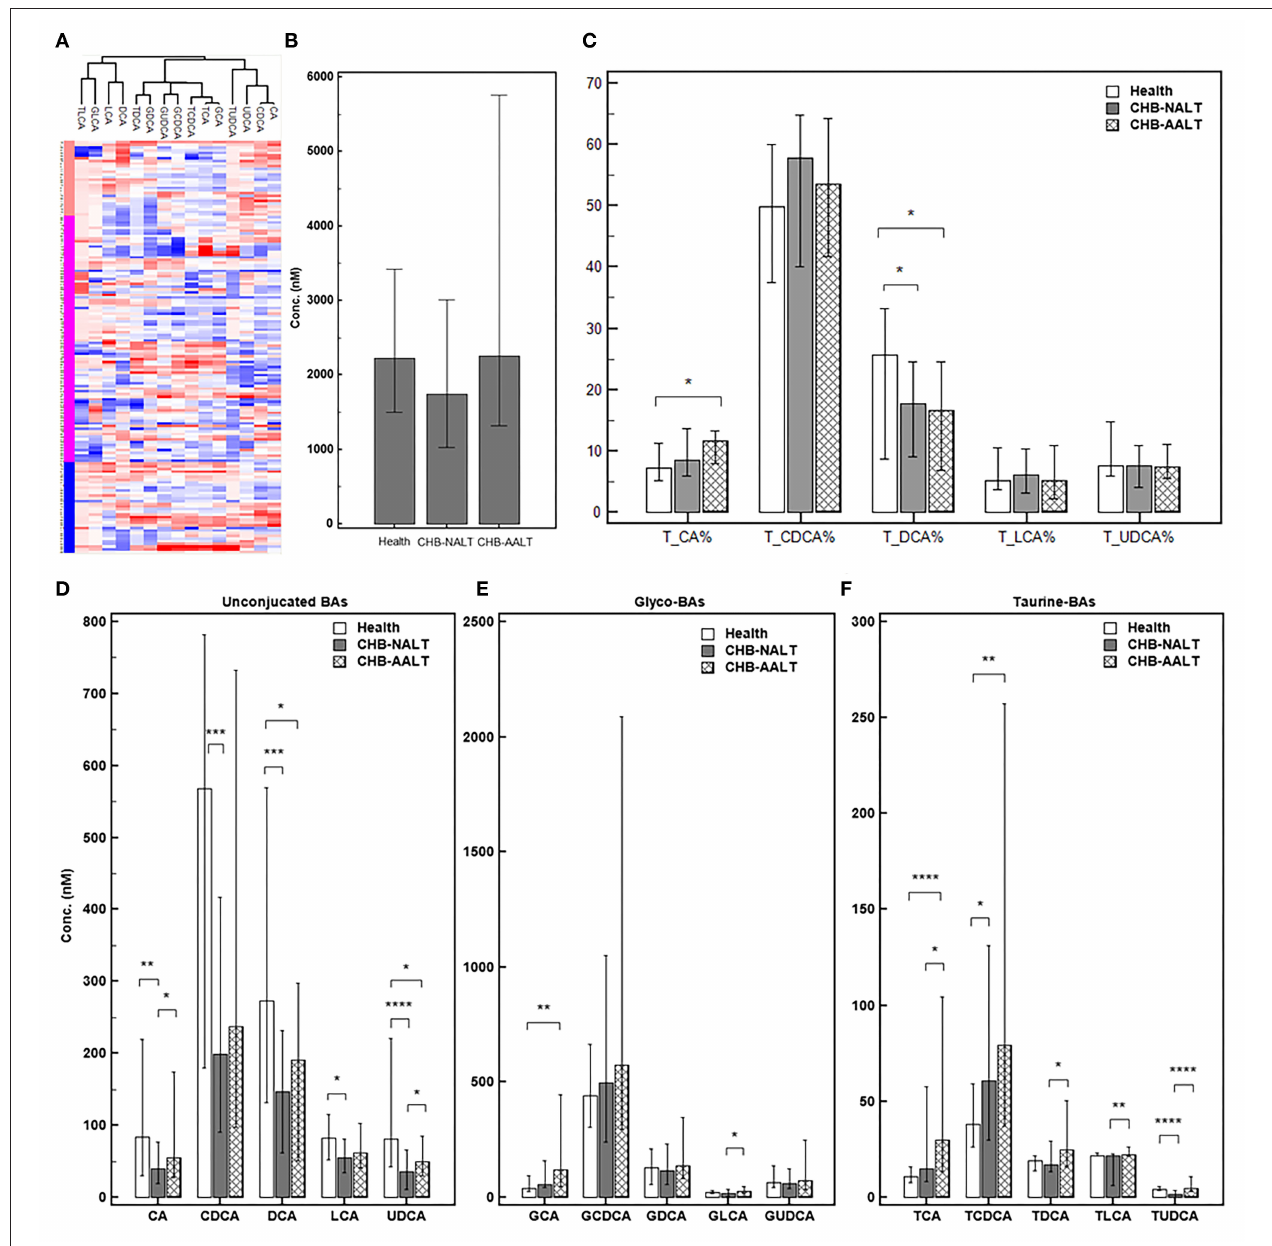
FIGURE 1 | Summary of BA profiles. (A) Bile acid profiles across all samples were visualized by heatmap. Concentration of each BA in Log2 scale were transformed into Z-score by columns. The columns were clustered using the K-mean algorithm. The levels of (B) total BA, (C) percentage of total CA, CDCA, DCA, LCA and UDCA, and the levels of (D) each unconjugated, (E) glyco-conjugated and (F) taurine-conjugated BAs measured in different groups were summarized. Error bars represented 25–75% quartile. P values were determined by the Mann–Whitney U test, significant differences were noted by * p < 0.05, ** p < 0.01, *** p < 0.001, **** p < 0.0001. CHB-NALT: ALT normal patient group, CHB-AALT: ALT abnormal patient